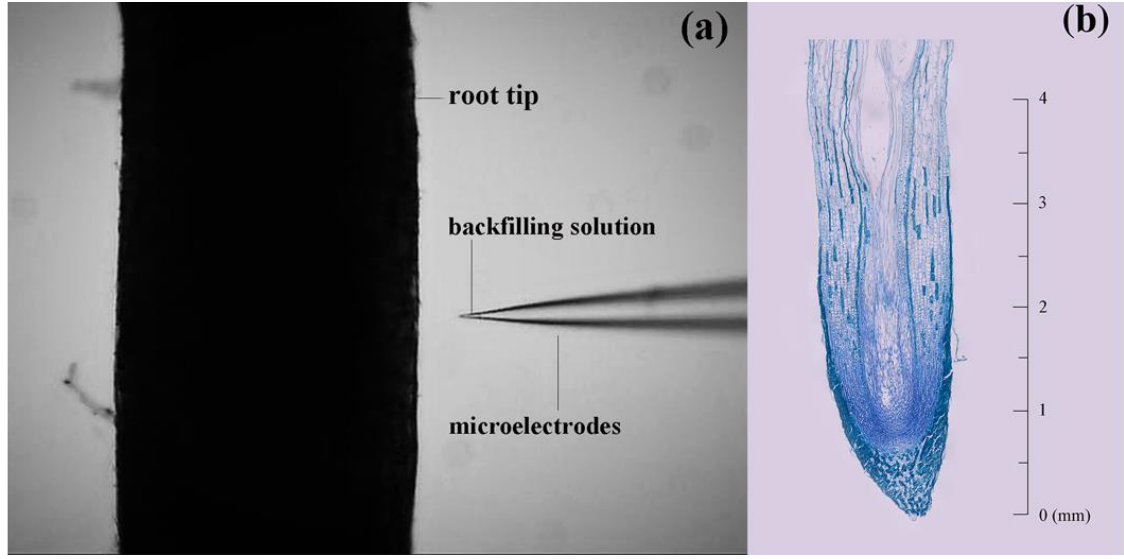
Figure 1. Root tip in NMT experiment ( a ) and the vertical section in the root of T. distichum ( b ). The measurement procedures were described by Zhao et al. [5]. Firstly, ion-selective mi- croelectrodes designed with 2–4 µ m apertures were manufactured and silanized. Secondly, for the NH 4+ electrode, in sequence, 100 mM NH 4 Cl was used as a backfilling